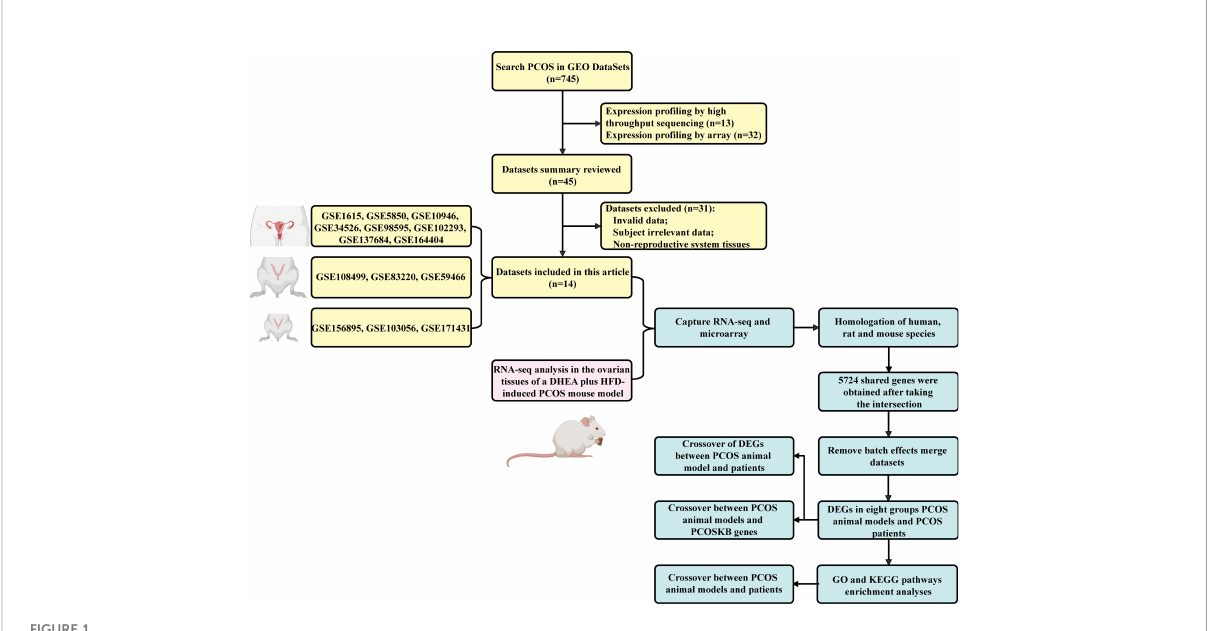
FIGURE 1 The work fl ow used in this study is